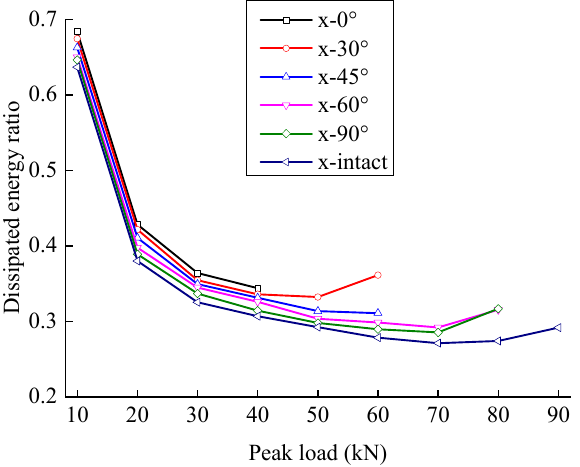
Figure 11. Energy storage ratio evolution curve of fractured sandstone with different crack angles.